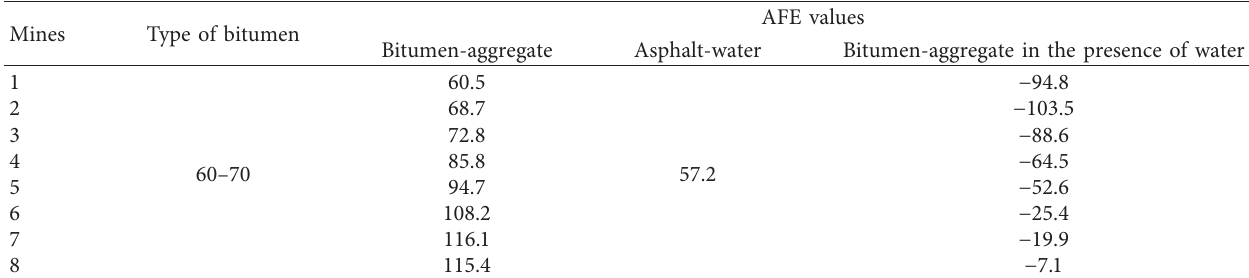
Table 9: Adhesion free energy values (erg/cm 2 ).